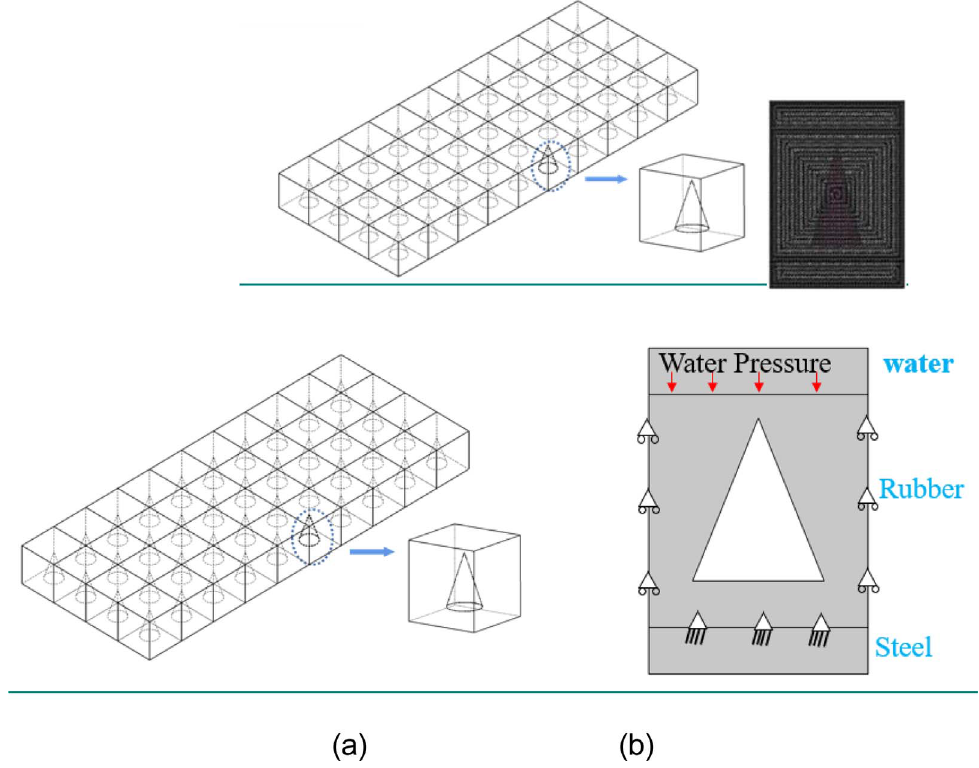
Figure 2. Schematic diagram of anechoic structure. (a) Acoustic covering layer unit cell; (b) mesh